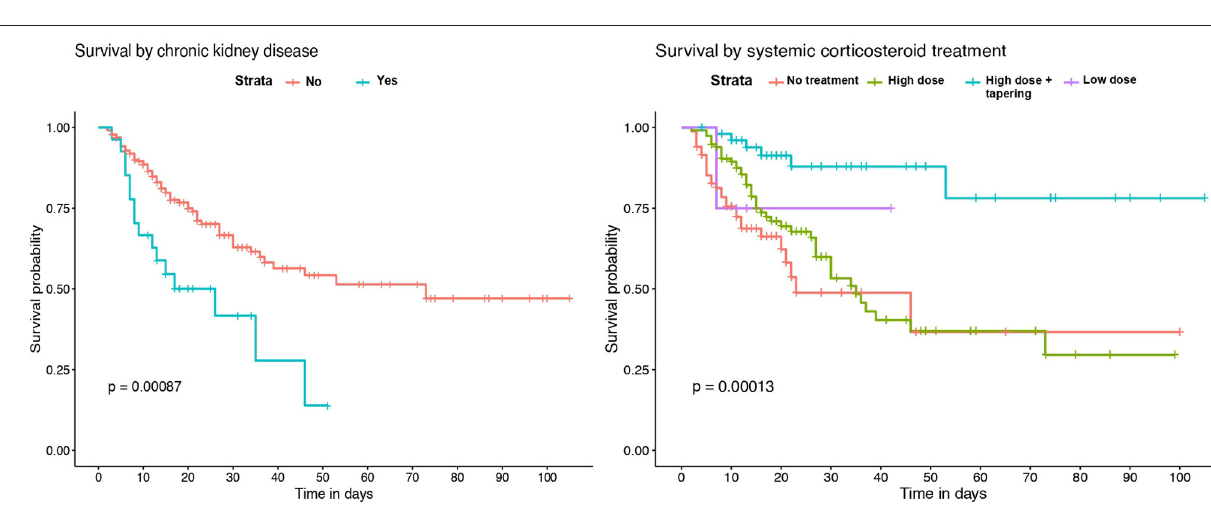
FIGURE 3 | Kaplan–Meier survival analysis by previous chronic renal disease and systemic corticosteroid